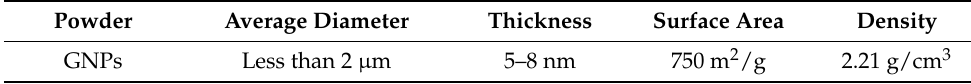
Table 3. Characteristics of